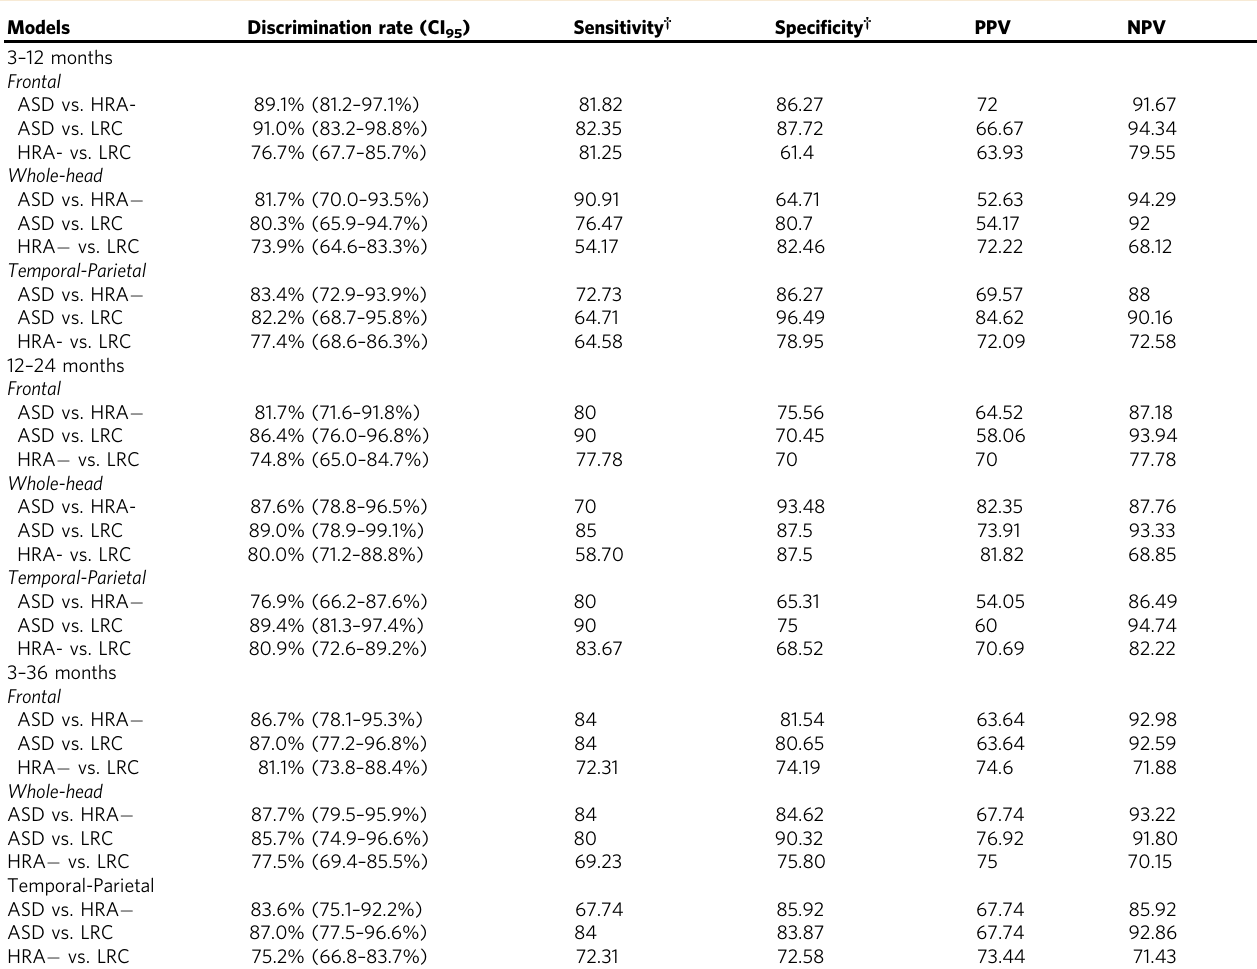
Table 1 Model performance metrics discriminating autism groups